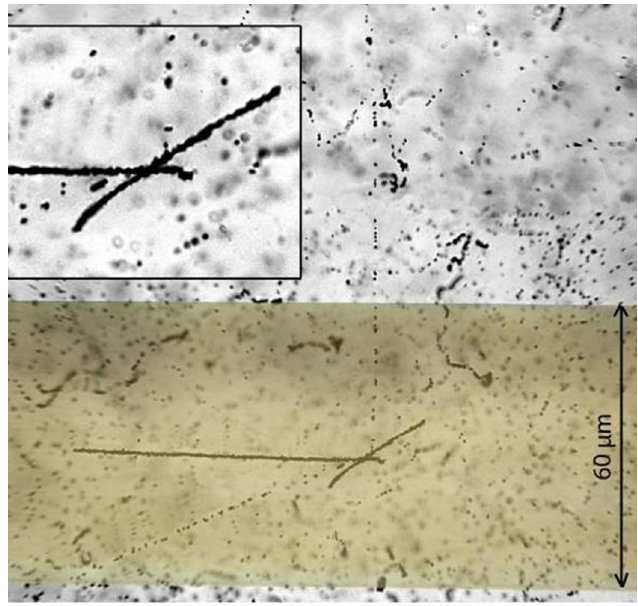
Figure 2. Mosaic macrophotography of a hammer-like decay of 8 He nucleus (horizontal track) stopped in nuclear track emulsion. Pair of electrons (point-like tracks) and pair of α -particles (short opposite tracks). On insertion (top): enlarged decay vertex. To illustrate special resolution the image of the decay is superimposed to macrophotography of a human hair of thickness of 60 μ